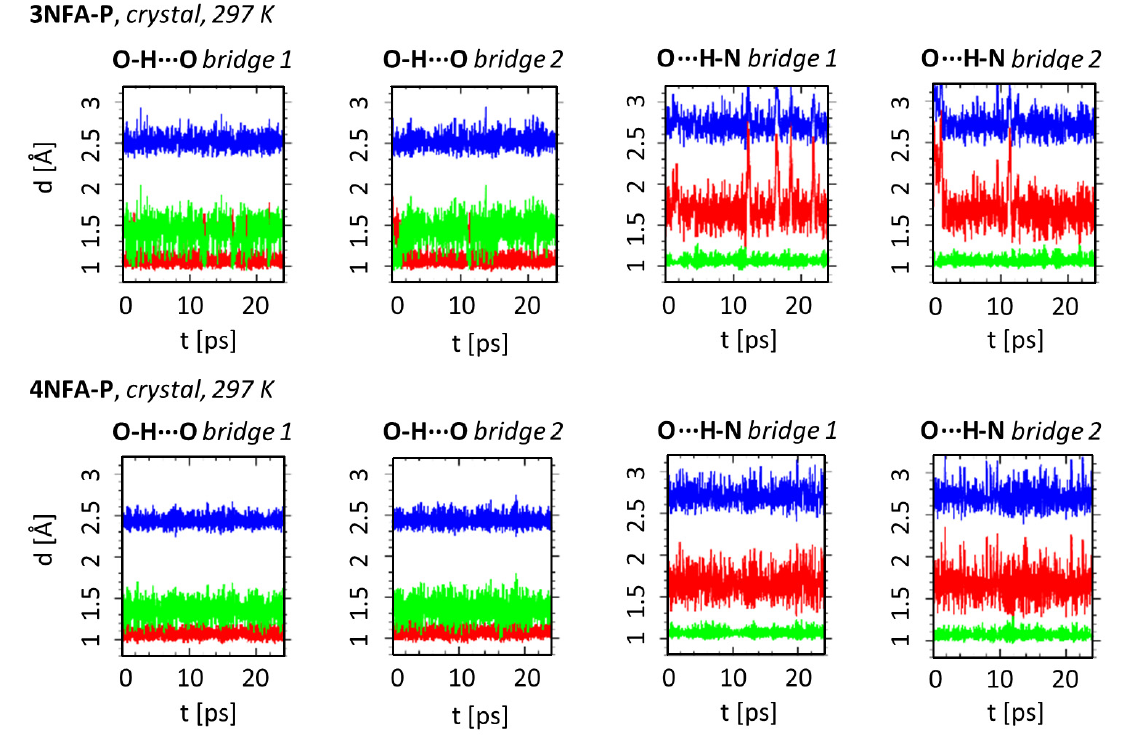
Figure 4. Time-evolution of the OHO and OHN hydrogen bonds metric parameters—results of CPMD solid state (T = 297 K) simulations of complexes 3NFA-P and 4NFA-P . The colors used in the graphs denote respectively: red–donor-proton distance, green–proton-acceptor distance, blue–donor-acceptor distance. This figure shows the dynamics of two hydrogen bridges denoted as bridge 1 and bridge 2 because two complexes are observed in crystal cell.